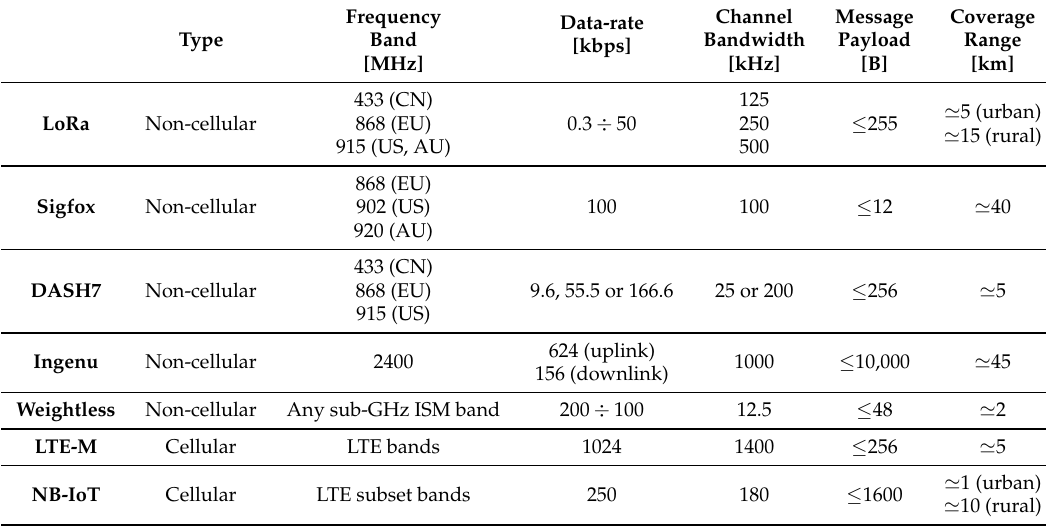
Table 1. LPWAN main enabling technology